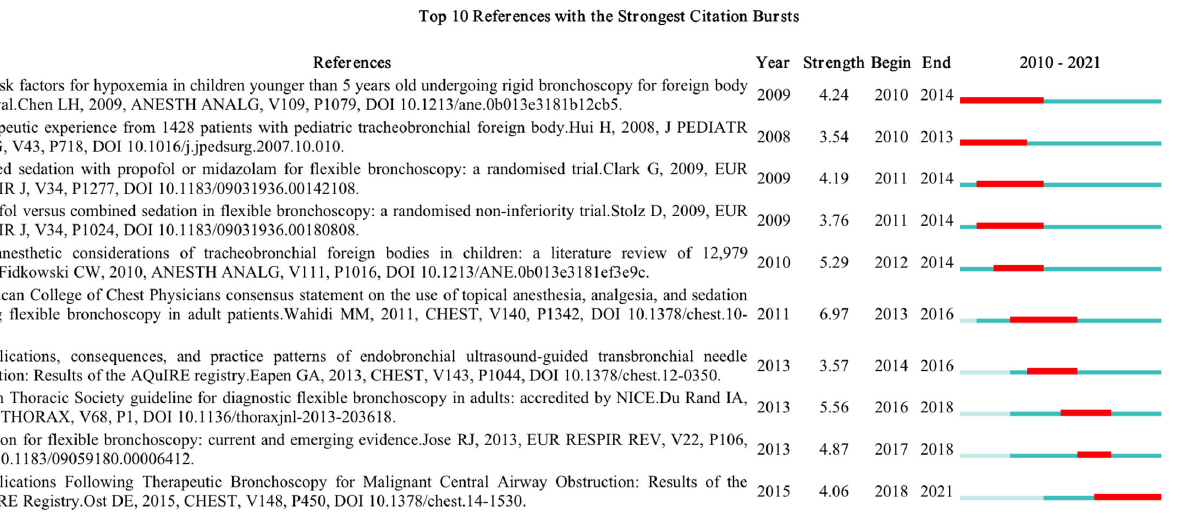
FIGURE 7 | Top 10 references with strong citation burstness (MD = 2). The red bars mean some references are cited frequently; the blue bars represent references cited infrequently.